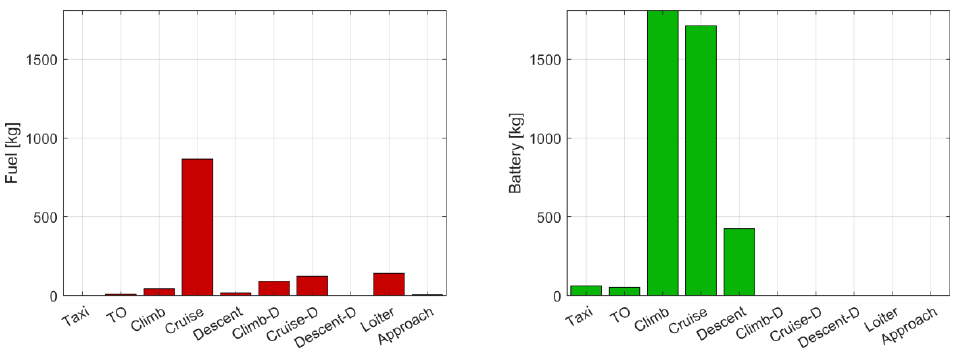
Figure 10. Mission simulation outcome: thermal (left), electric (centre), total (right) power sup- plied.